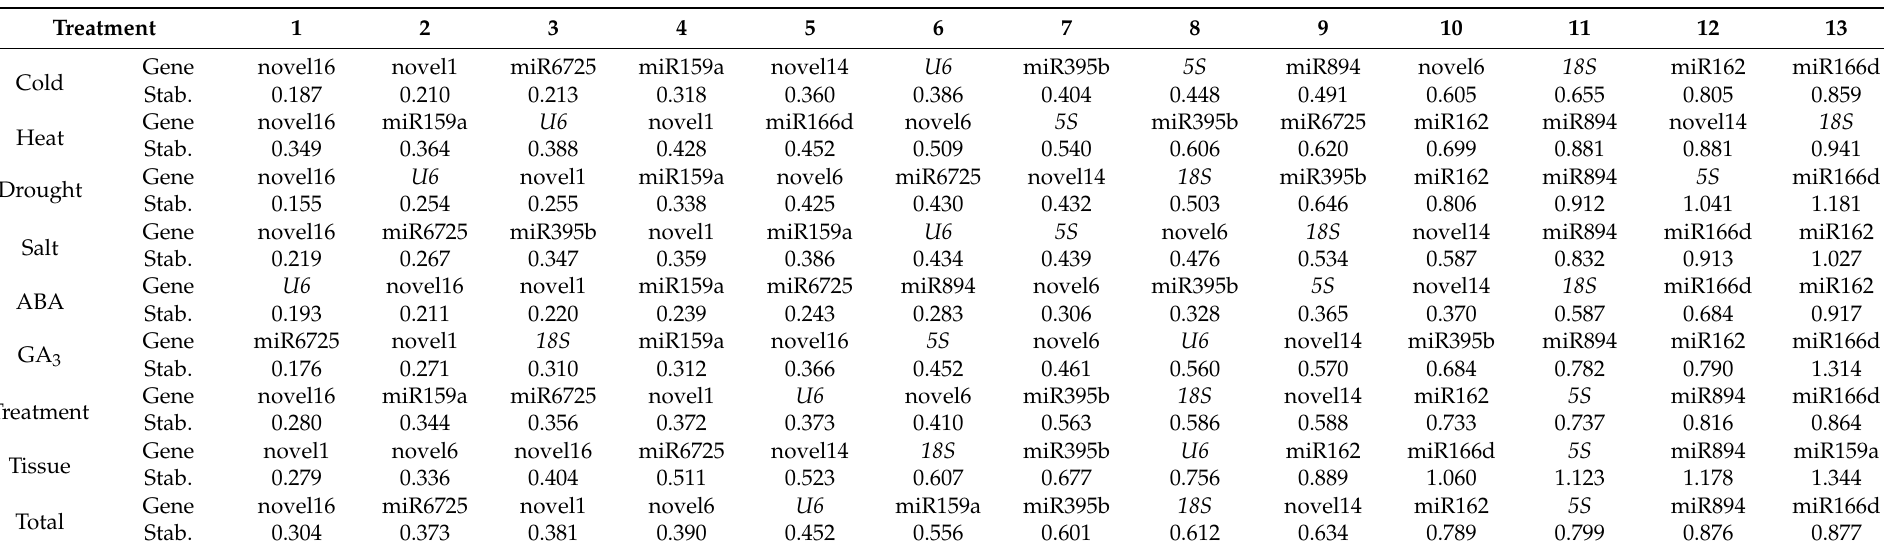
Table 2. Expression-stability values and the ranking of reference genes calculated by